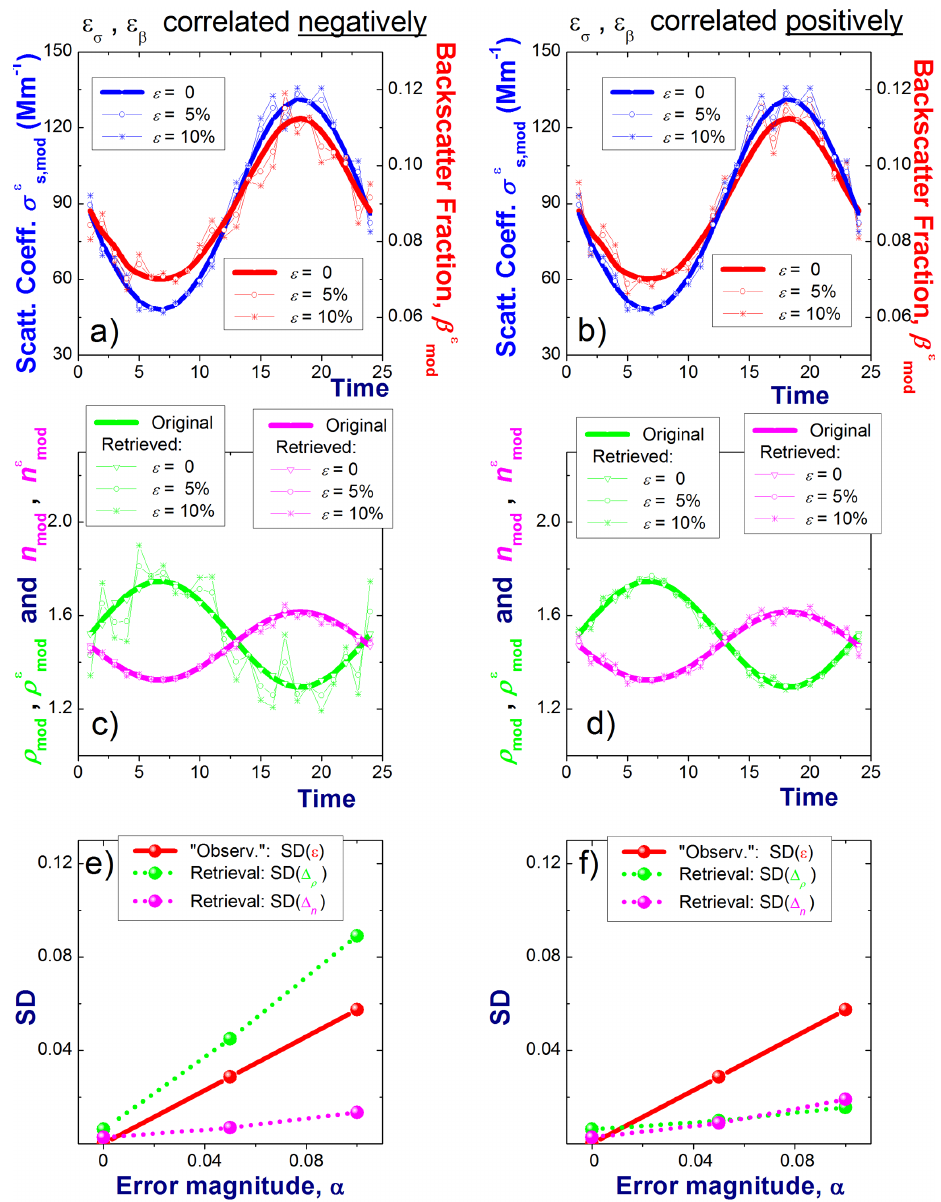
) with different Figure 2. Example of (a, b) modeled aerosol optical properties (scattering coefficient σ ε and backscatter fraction β ε s , mod mod magnitudes (0, 5, and 10%) of the added errors ( ε σ and ε β ) ; (c, d) the corresponding “retrieved” aerosol characteristics (effective density ρ ε ) and their original counterparts ( ρ mod and n mod ) ; and (e, f) the standard deviation (SD) of differences and real refractive index n ε mod mod between the original and retrieved aerosol characteristics ( 1 ρ and 1 n ) and the SD of the “observational” errors for two extreme cases: the observational errors ( ε σ and ε β ) are correlated negatively (left column) and positively (right column). See text for